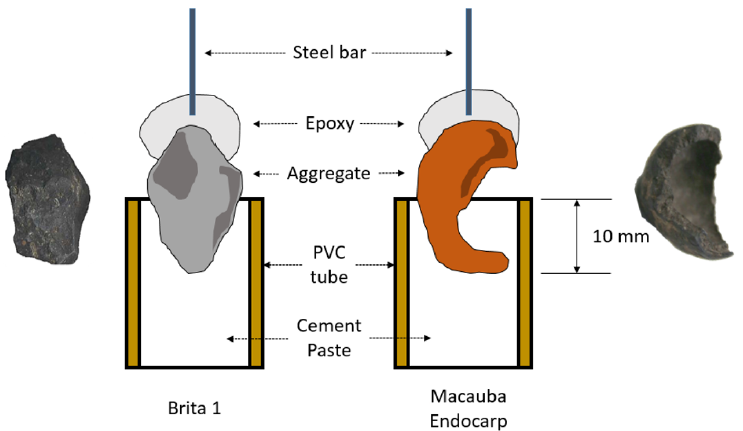
Figure 6. Aggregate pull-out test setup: crushed granite ( left ) and semi ellipsoidal-shaped crushed endocarp ( right